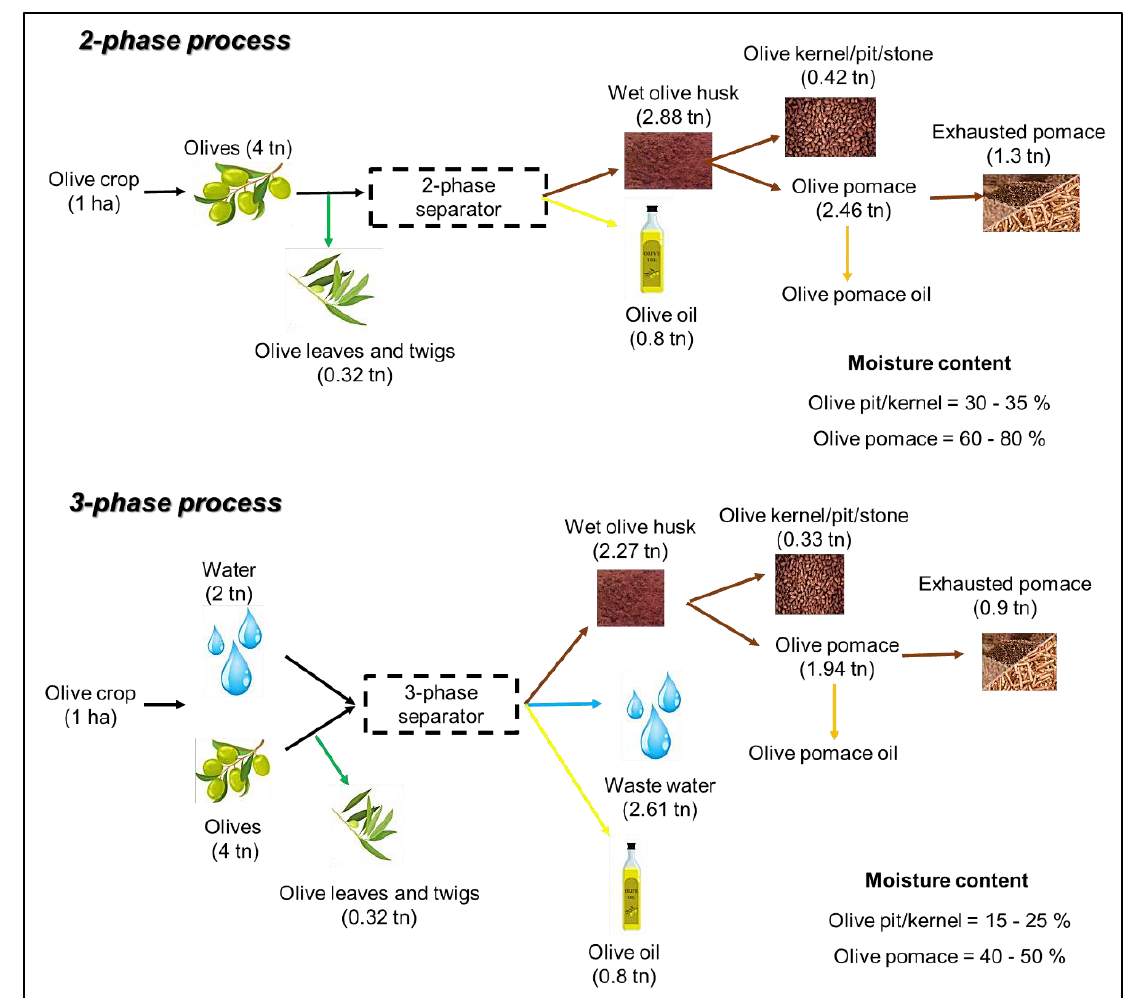
Figure 3. Two- and three-phase olive oil extraction process.